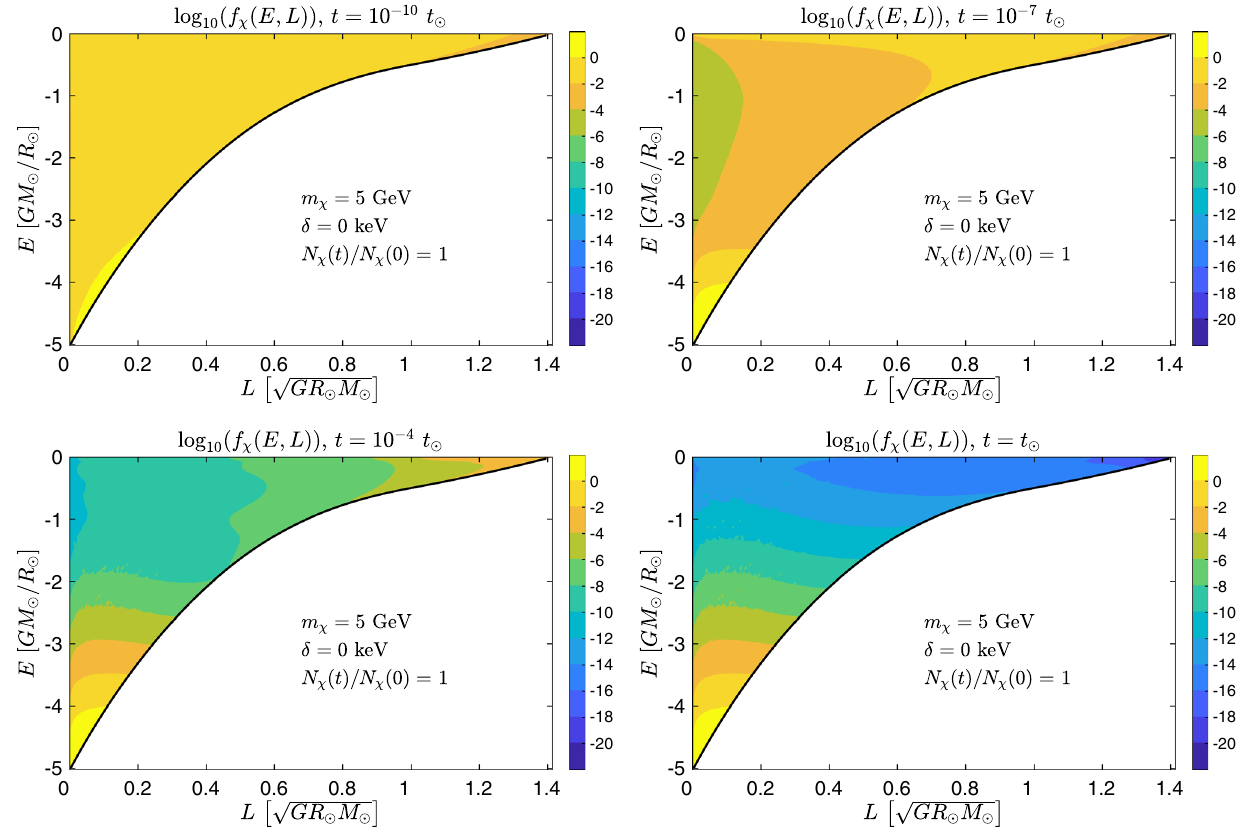
Fig. 4 The base 10 logarithm of the distribution of dark matter at various times t / t (cid:9) = 10 − 10 , 10 − 7 , 10 − 4 and 1 for an initial distribution (cid:8) f ( 0 ) = (cid:8) C (cid:17) t . We use elastic scattering with m χ = 5 GeV